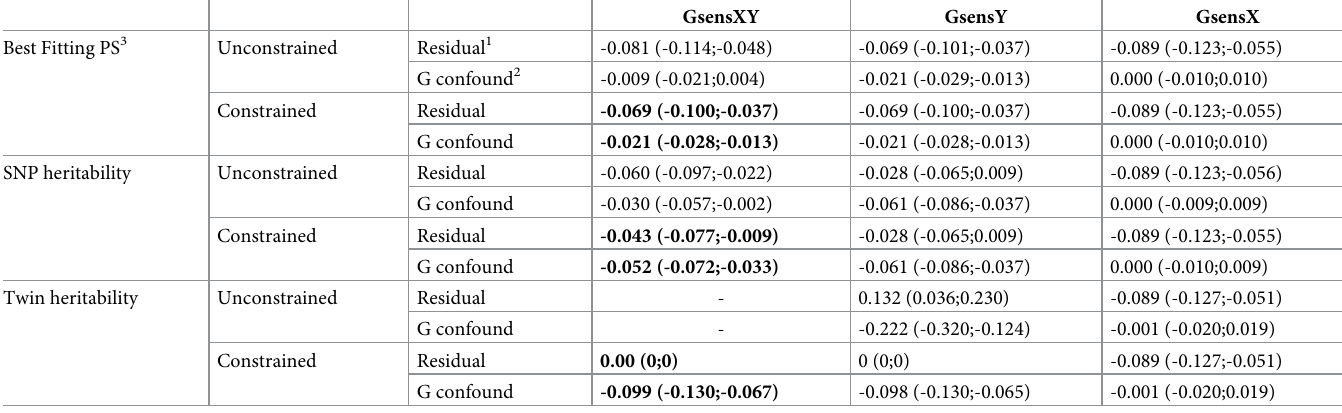
Table 2. Sensitivity analysis for BMI.